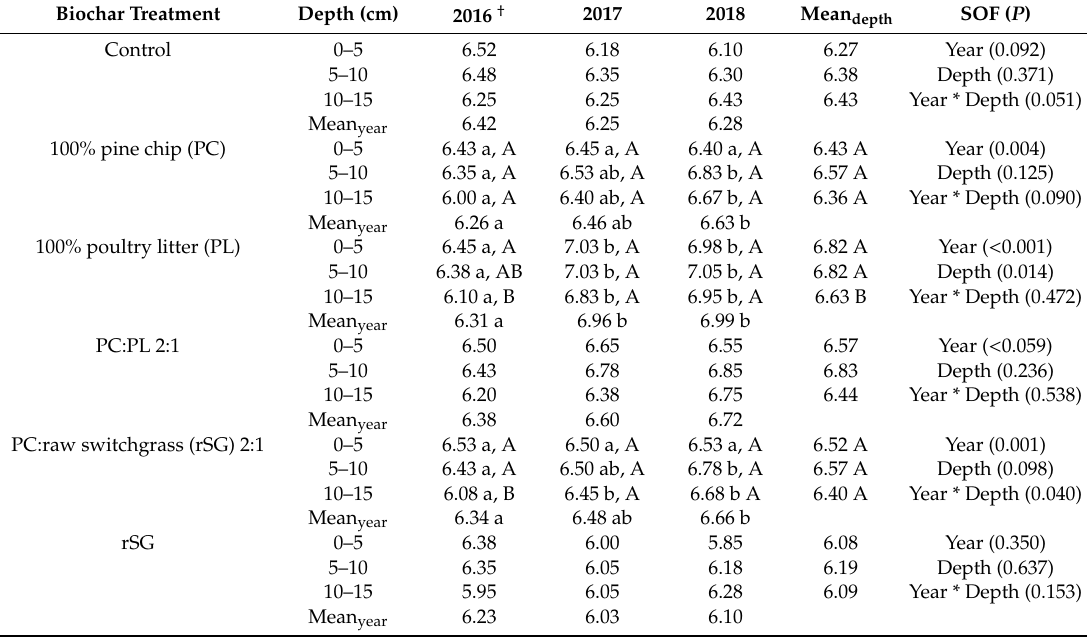
Table 8. Mean pH by soil depth per year of study (SOV = source of variation, P value in brackets). Biochar Treatment